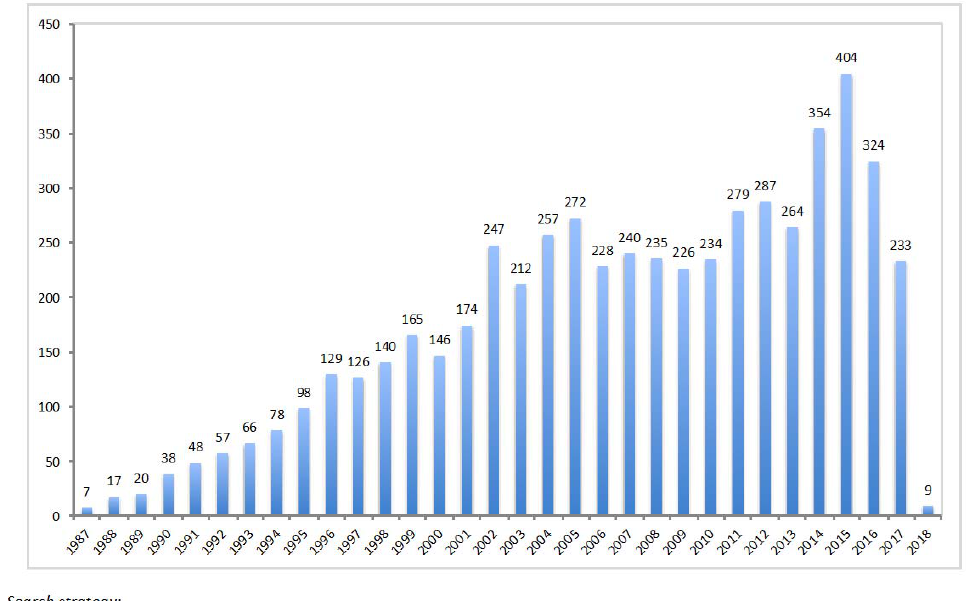
Figure 1. Number of publications on HIV/AIDS recorded yearly in PubMed by Spanish authors.